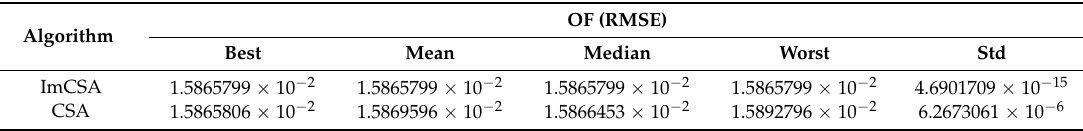
Table 10. Statistics of the OF (RMSE) values for the PMM of polycrystalline STP6-120/36 panel using the proposed ImCSA and CSA.